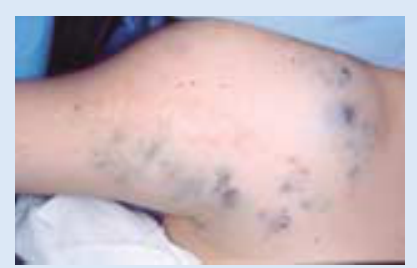
Fig. 3a. Large venous malformation of a lower limb. No leg length discrepancy was